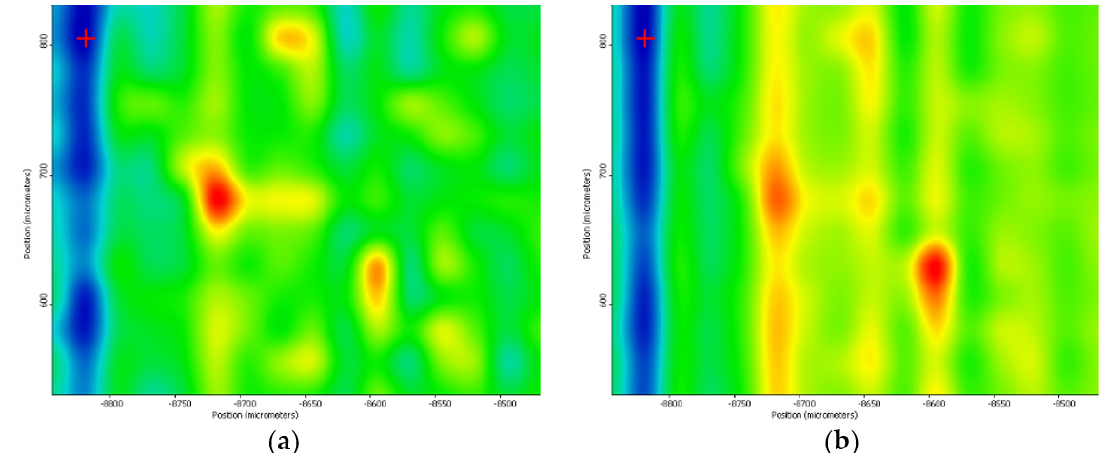
Figure 13 Figure 13. IR maps of PVP/ZnO@LiN based on the distribution of C–H ( a ) and C=O ( b ) bonds at 400 mJ/cm 2 laser fluence.